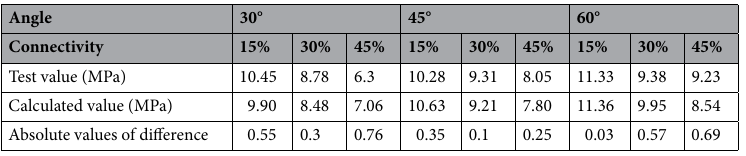
Table 6. Calculated peak strength of fractured soft rock.